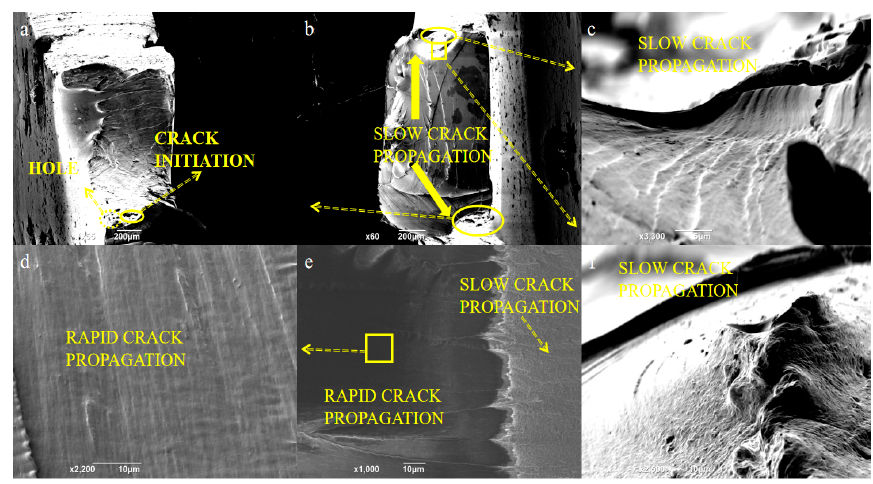
Figure 12. Fracture surface of the TPU sample (gold spray) at 13.08 MPa.( a ) Micropore on fracture surface.( b )Fracture surface morphology.( c ) The slow crack propagation.( d )Smooth surface morphology of the rapid crack propagation.( e )The rapid crack propagation.( f ) Surface roughness morphology of the slow crack propagation.